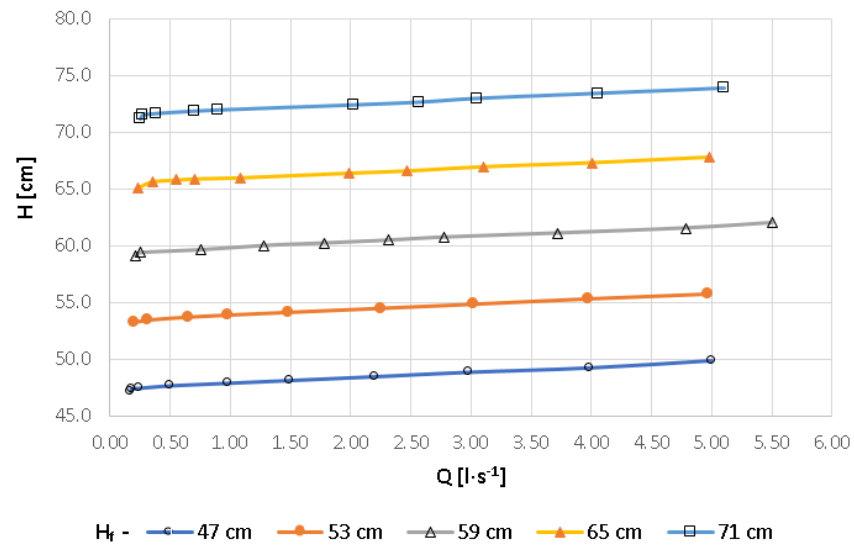
Figure 4. Effective discharge Q e of a funnel regulator, depending on the height of the funnel overflow edge position above the drain axis H f .